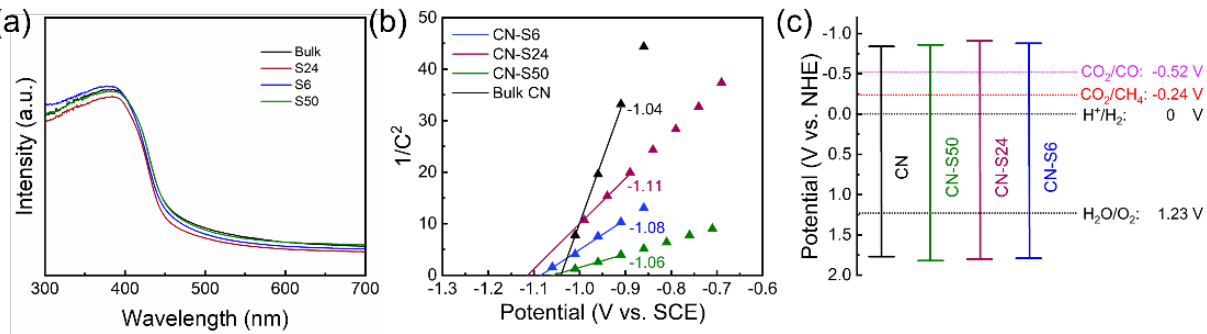
Figure 2. TEM images of the synthesized CN ( a ) and CN-S24 ( b ) samples; EDS mapping of CN-S24 ( c – f ).